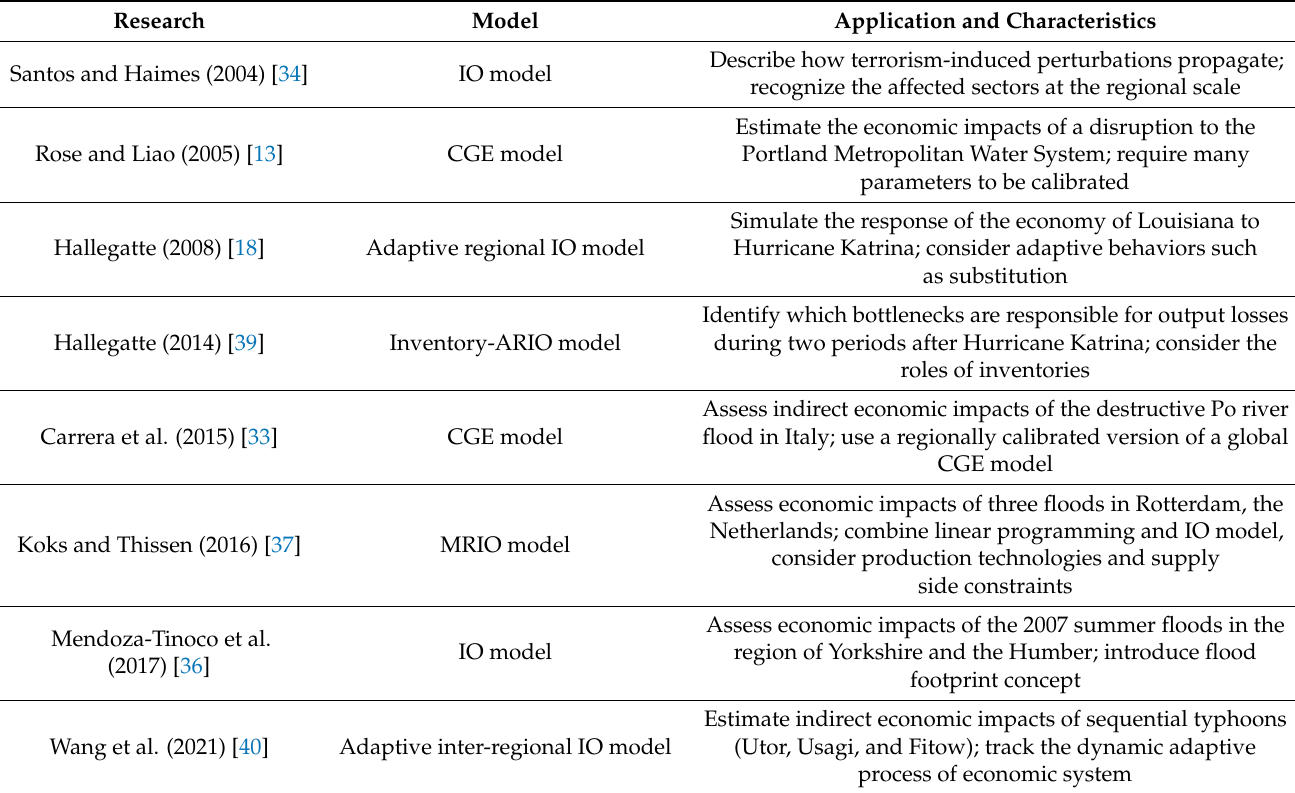
Table 1. Overview of models measuring indirect economic losses of